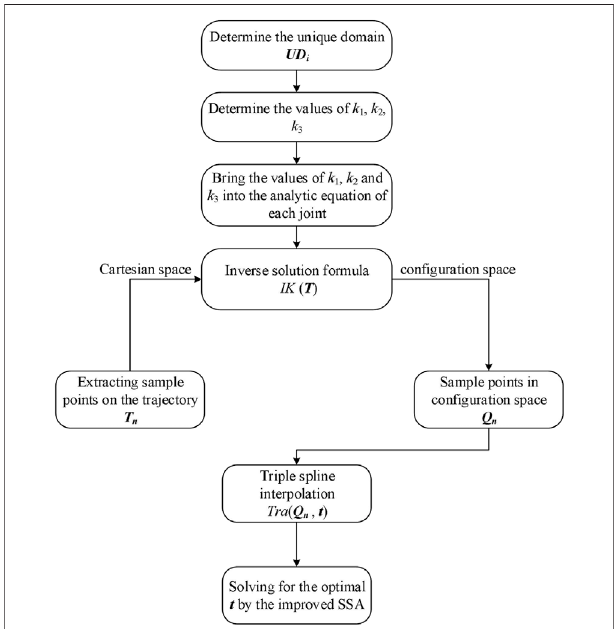
FIGURE 3 | Time-optimal algorithm fl ow for trajectories.